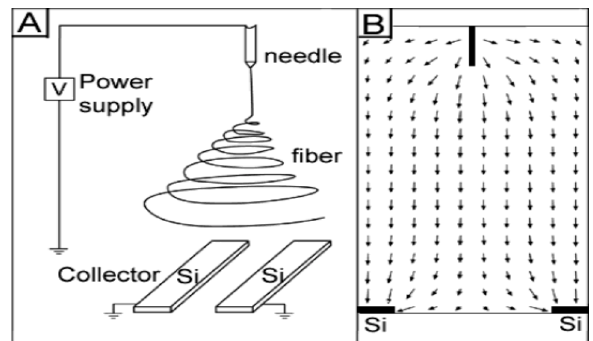
Figure 14. Schematic diagram showing electrospinning setup for forming uniaxially aligned nanofibers. ( A ) A collector with two pieces of conductive silicon stripes separated by a gap. ( B ) Electric field strength around the needle and the collector. The arrows denote the direction of the electrostatic field lines. Reproduced with permission from [135], published by American Chemical Society, 2003.